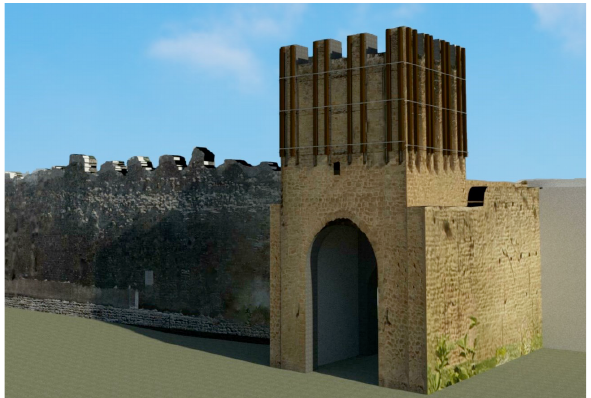
Figure 5. The textured 3d model of Porta Picena and the adjacent wall (©